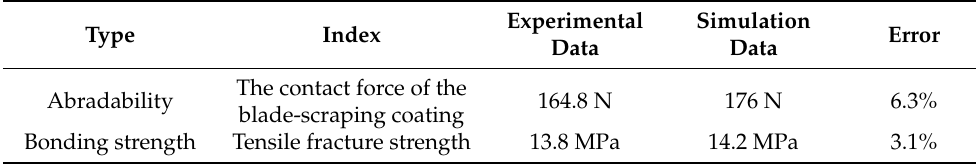
Table 5. Data comparison for simulation and experimental